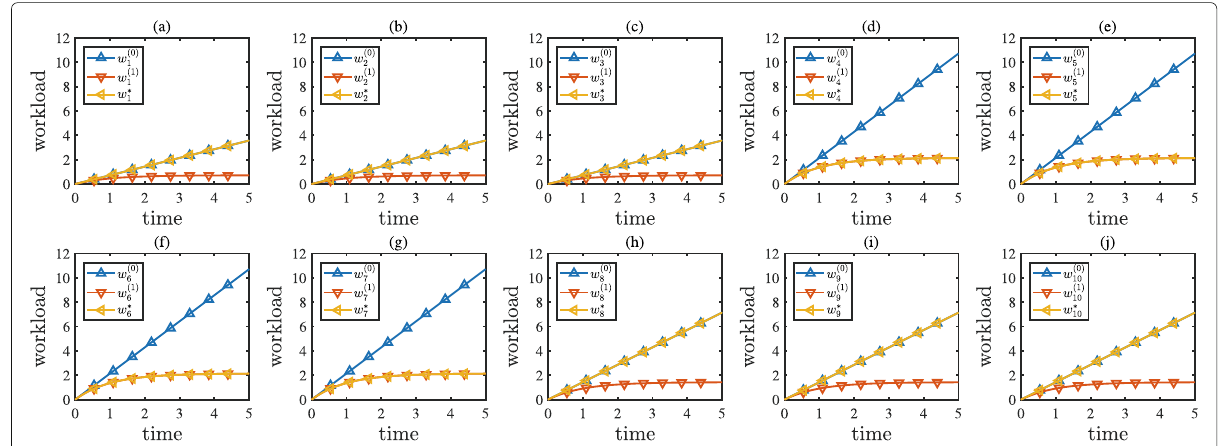
Fig. 6 The workload distribution evolution obtained from Example 1, where ( a ) to ( j ) show the workload dynamics of servers s 1 , s 2 , ... , s 10 in